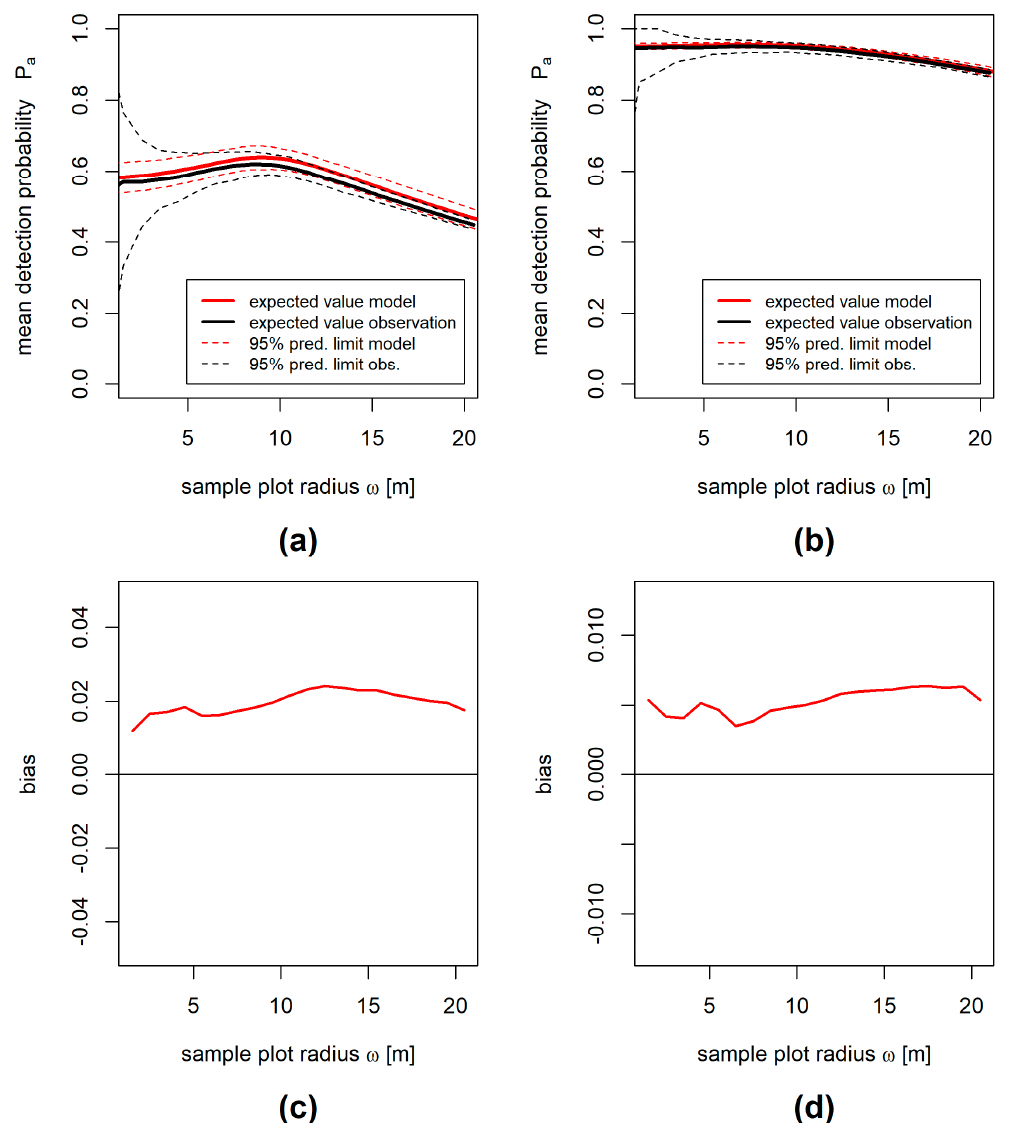
Figure 8. Results of the simulation study (200 simulation runs of 25 sample plots) for both strata, using annuli of 1 m widths for model fitting to the simulated multi-scan data. ( a , b ) Mean detection probability P a for di ff erent sample plot radii ω using simulated TLS in multi-scan mode. The solid black line represents the expectation of the simulated data; the solid red line represents the expectation of the model prediction. The dashed lines represent the corresponding 95% prediction limits, i.e., the 2.5% and 97.5% quantiles of the 200 simulation runs. ( c , d ) Model bias dependent on the sample plot radius. ( a , c ) Small trees (5 cm ≤ dbh < 20 cm) and ( b , d ) large trees (dbh ≥ 20 cm).